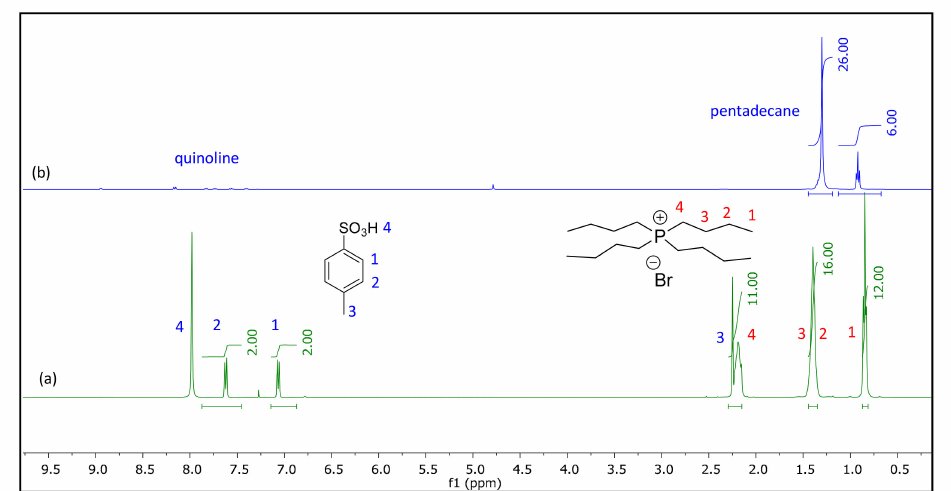
Figure 7. NMR spectra of TBPBr / PTSA DES (1:1, molar ratio) in CDCl3.